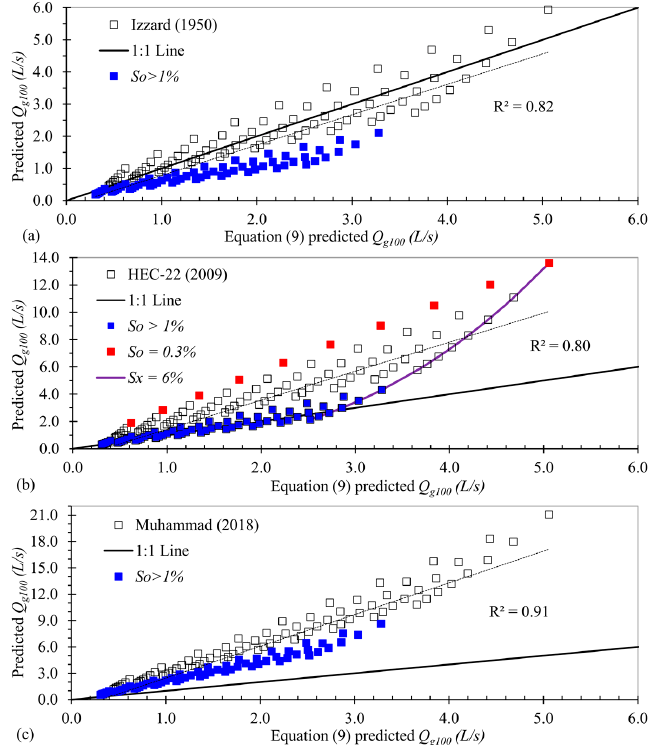
Figure 6. Comparison of predicted 100% interception gutter flow Q g 100 of L ci = 5 ft (1.524 m)